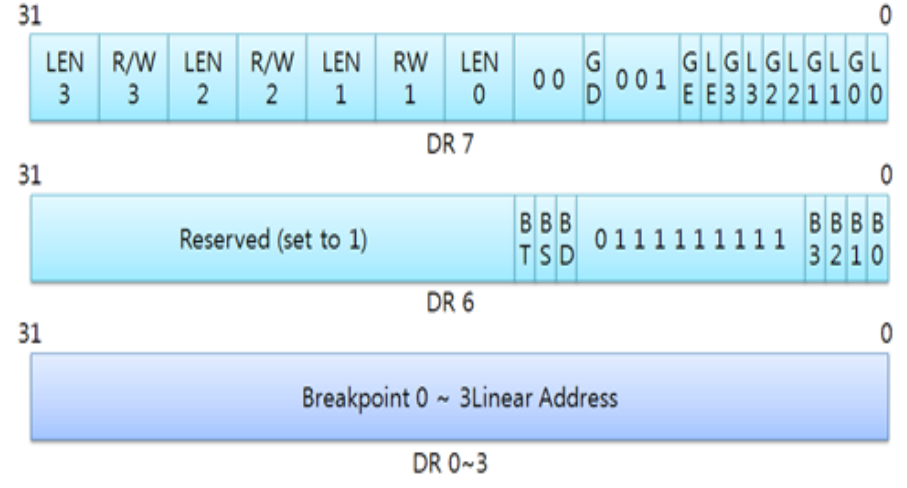
Figure 12. The structure of debug registers.